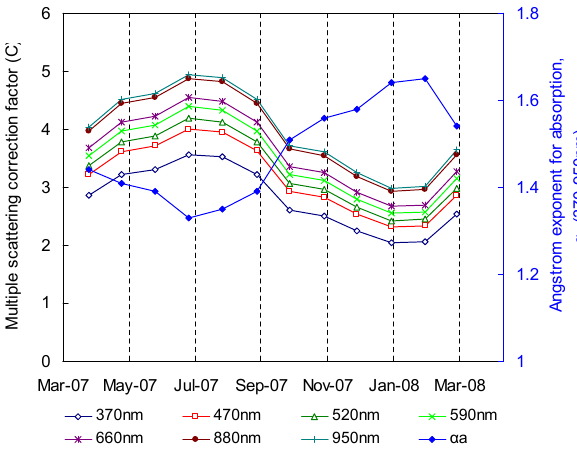
Fig. 4. Determination of the ˚Angstr¨om exponent for absorption ( α a ) in the range of 370nm–950nm and multiple scattering correction factor (C) at the measurement